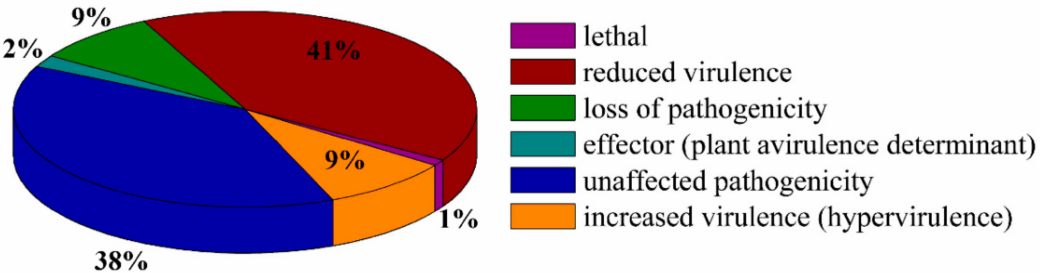
Figure 2. Summary of different phenotypic categories of orthologs of T. asperellum ND-1 secretome genes in the pathogen-host interactions (PHI-base)